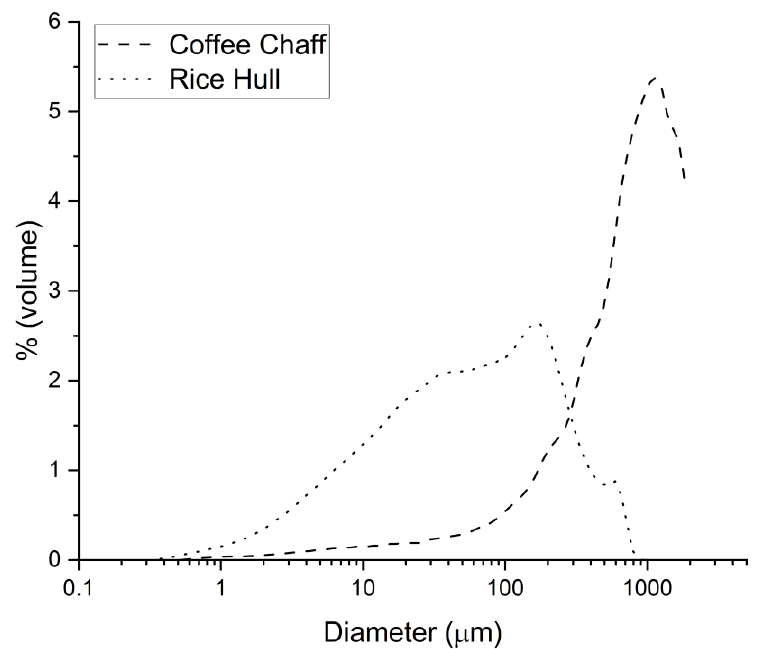
Figure 5. Particle size distribution for coffee chaff (dashed line) and rice hull (dotted line).